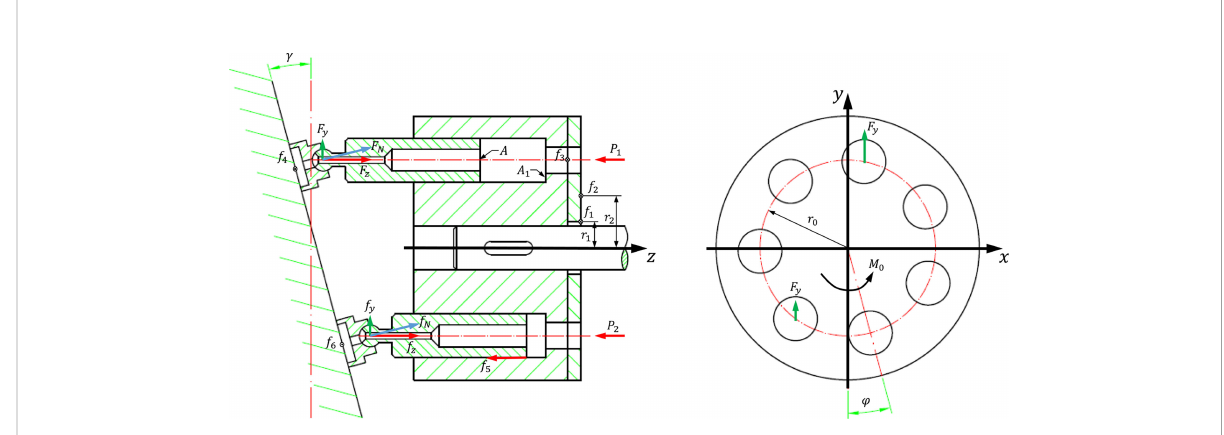
FIGURE 3 The working principle and force analysis of the swashplate axial piston hydraulic